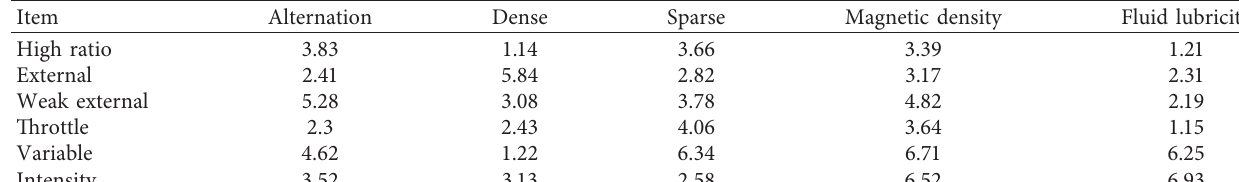
Table 5: Approximate degree of dynamic contact lubricity of the joint surface.